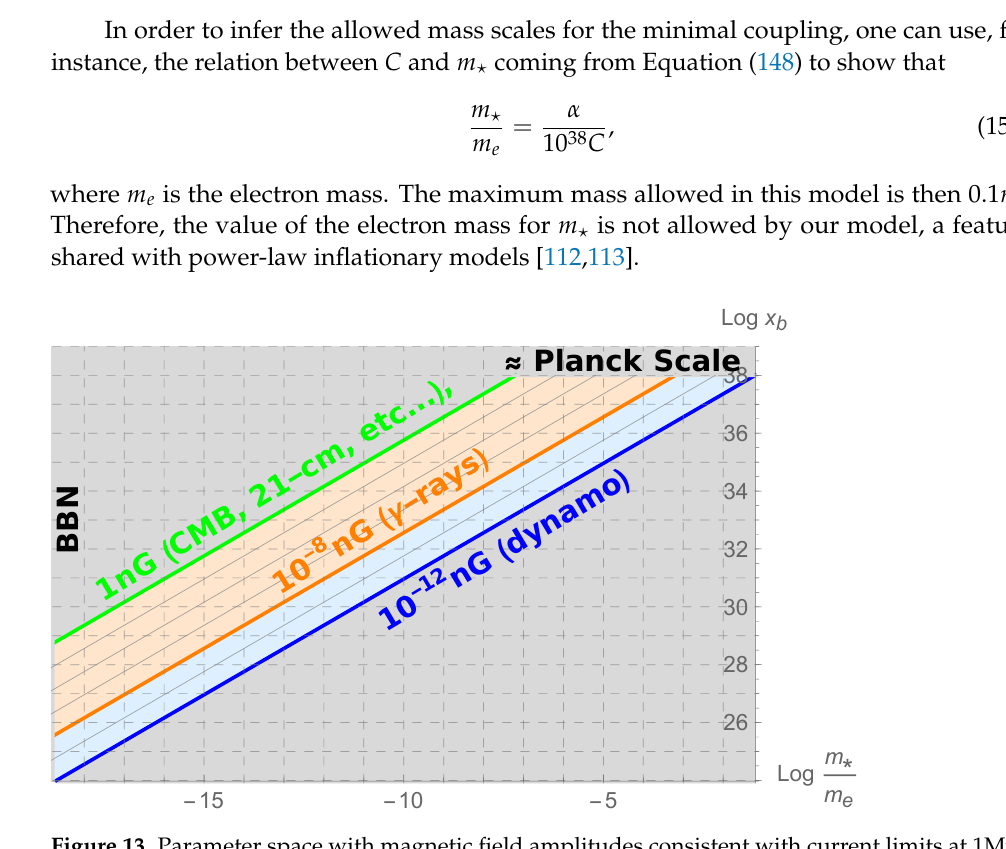
Figure 13. Parameter space with magnetic field amplitudes consistent with current limits at 1Mpc. The blue region shows the allowed values to initiate the dynamo effect. The blue line is its theoretical lower limit [115]. The orange region represents allowed values coming from observations at large scales in voids, the orange line is the lower limit derived by blazars observations [124], and the green line is the upper limit derived using Ultra-High-Energy Cosmic Rays, Ultra-Faint Dwarf galaxies, 21-cm hydrogen lines, and so forth [125]. The orange and blue regions are overlapping. The grey shaded region denotes excluded values of the magnetic field. Each oblique grey line gives an amplitude for the magnetic field a hundred times higher than the lower